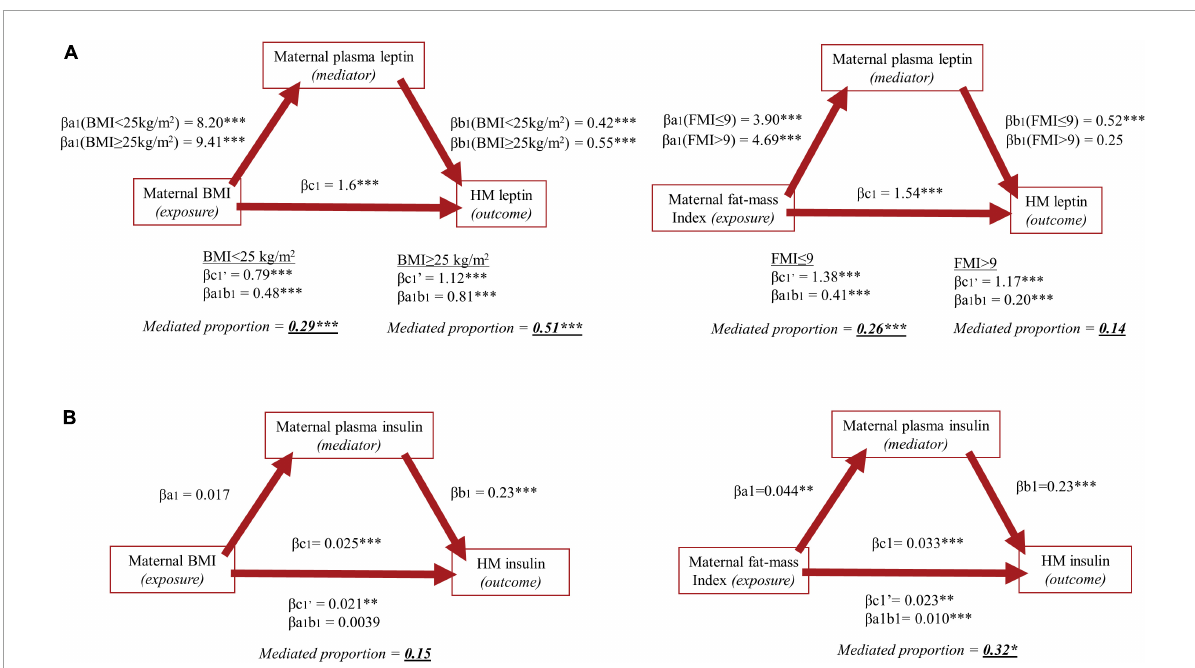
FIGURE3 Mediation analyses of Research Question 1 investigating the association between maternal body mass index (left) and fat-mass index (right) as exposure variables and human milk concentrations of (A) leptin and (B) insulin as outcome variables, with maternal plasma concentrations of the respective hormone as mediating variables. In mediation analyses including HM leptin, an exposure-mediator interaction resulted in categorization of maternal BMI into normal- or overweight (BMI < 25 or ≥ 25kg/m 2 ) and FMI into having normal or excessive fat mass (FMI ≤ 9 or > 9) and estimates are given for each group. No exposure-mediator interaction was present in mediation analyses including HM insulin, and the exposure variables were therefore not categorized and estimates are given accordingly.